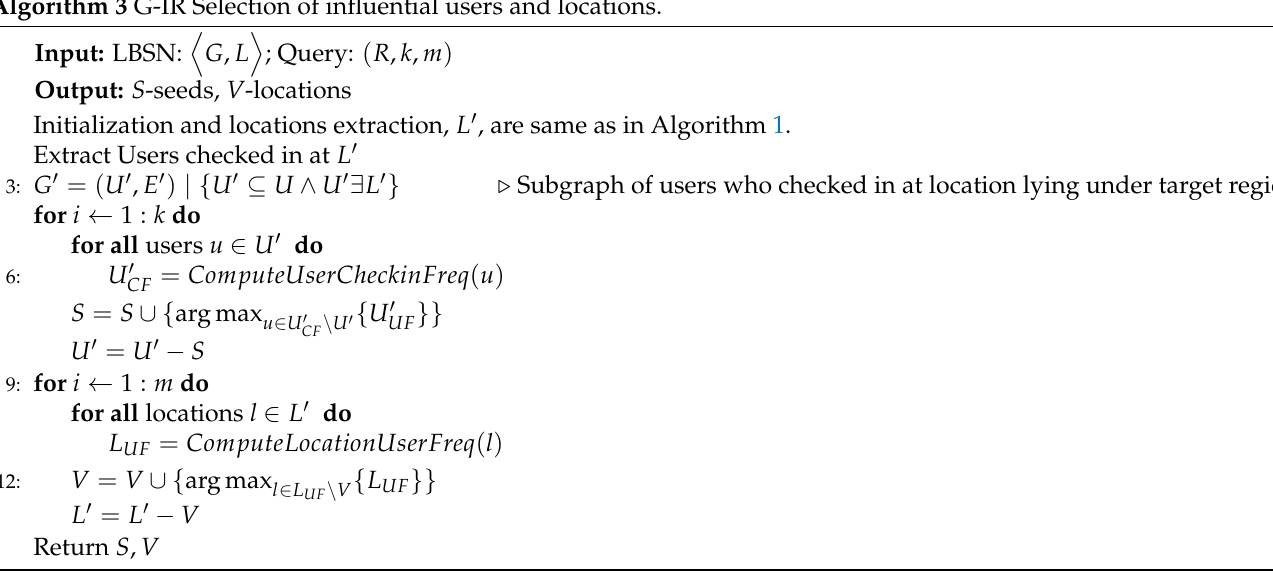
Algorithm 3 G-IR Selection of influential users and